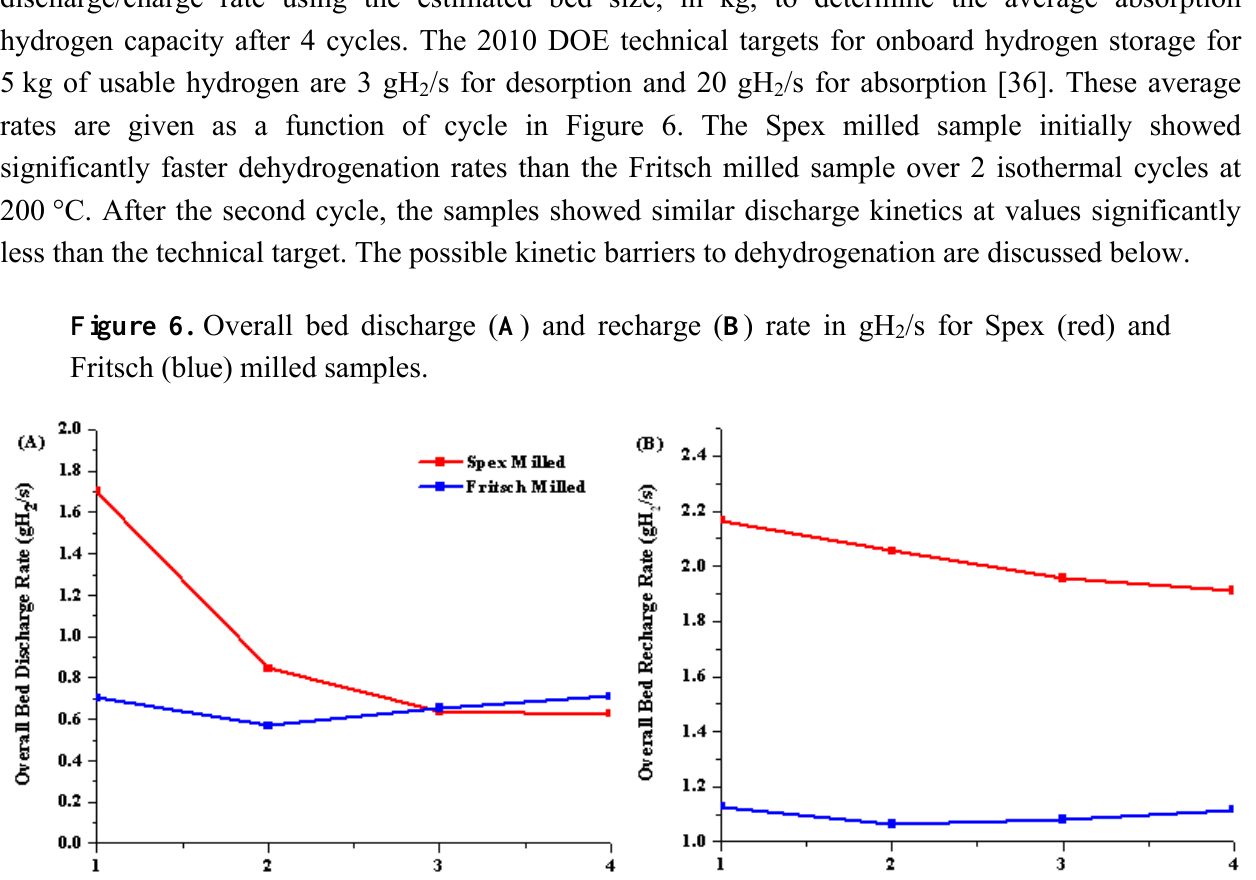
/s for Spex (red) and 2